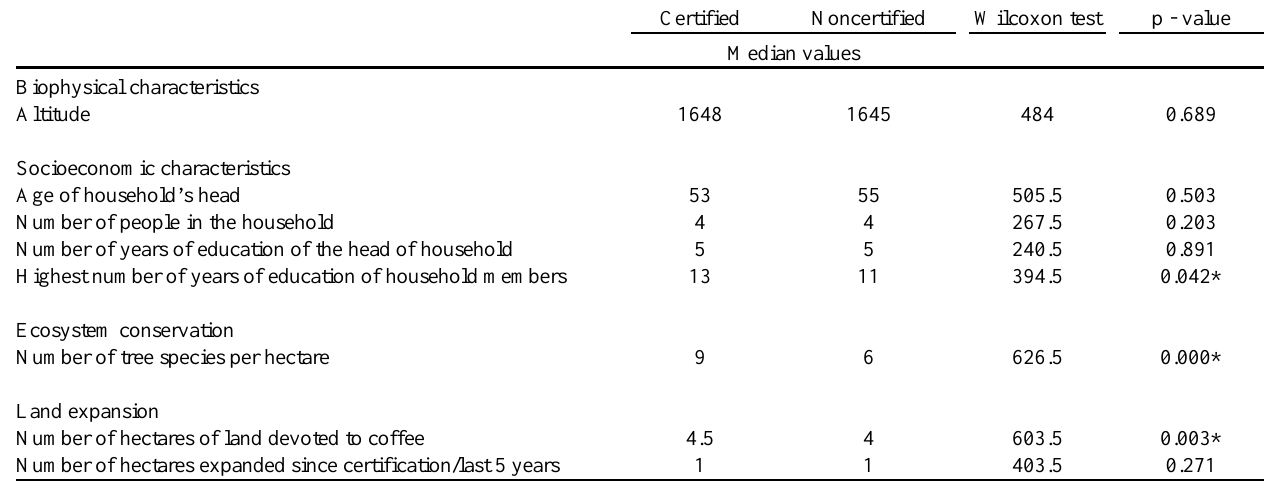
Table 1 . Difference in practices between certified and noncertified farms: continuous variables (n =